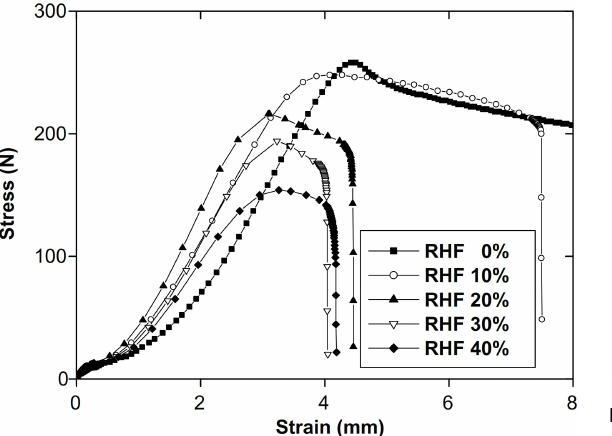
Figure 2: Stress strain curve for different wt. compositions of RH [8]